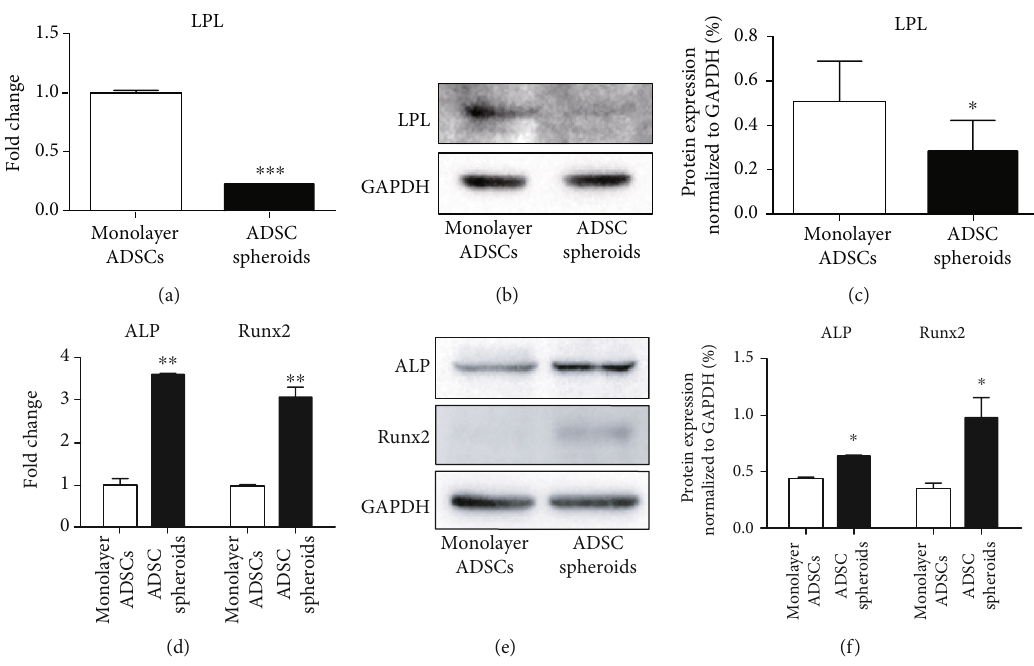
Figure 4: Di ff erentiation capabilities of monolayer ADSCs and ADSC spheroids after 7 days of adipogenic induction and 14 days of osteogenic induction. (a, d) qPCR measurements for adipogenic marker LPL and osteogenic markers ALP and Runx2 in monolayer ADSCs and ADSC spheroids. Data are displayed as mean ± SEM . ∗∗ P < 0 : 01 , ∗∗∗ P < 0 : 001 vs. monolayer ADSCs. (b, e) Western blot analysis of the expression of LPL, ALP, and Runx2 in monolayer ADSCs and ADSC spheroids. (c, f) Quanti fi cation of protein levels compared to GAPDH control. Data are displayed as mean ± SEM . ∗ P < 0 : 05 vs. monolayer